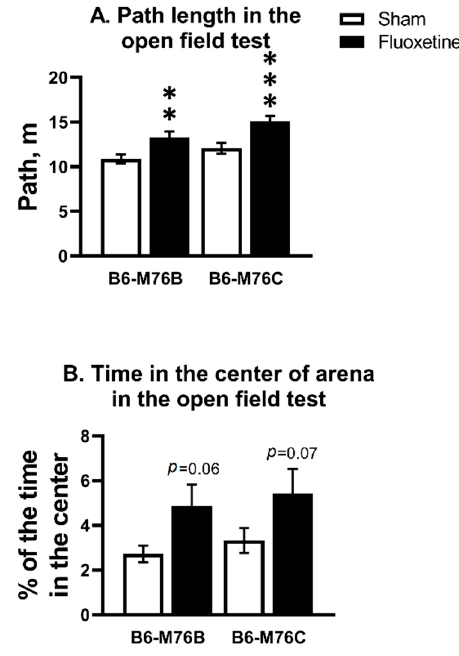
Figure 1. E ff ect of chronic fluoxetine administration on path length ( A ) and time in the center of arena ( B ) in the open field test. n ≥ 15 for each group. All values are presented as mean ± SEM. ** p < 0.01, *** p < 0.001 compared to control mice of the same line.